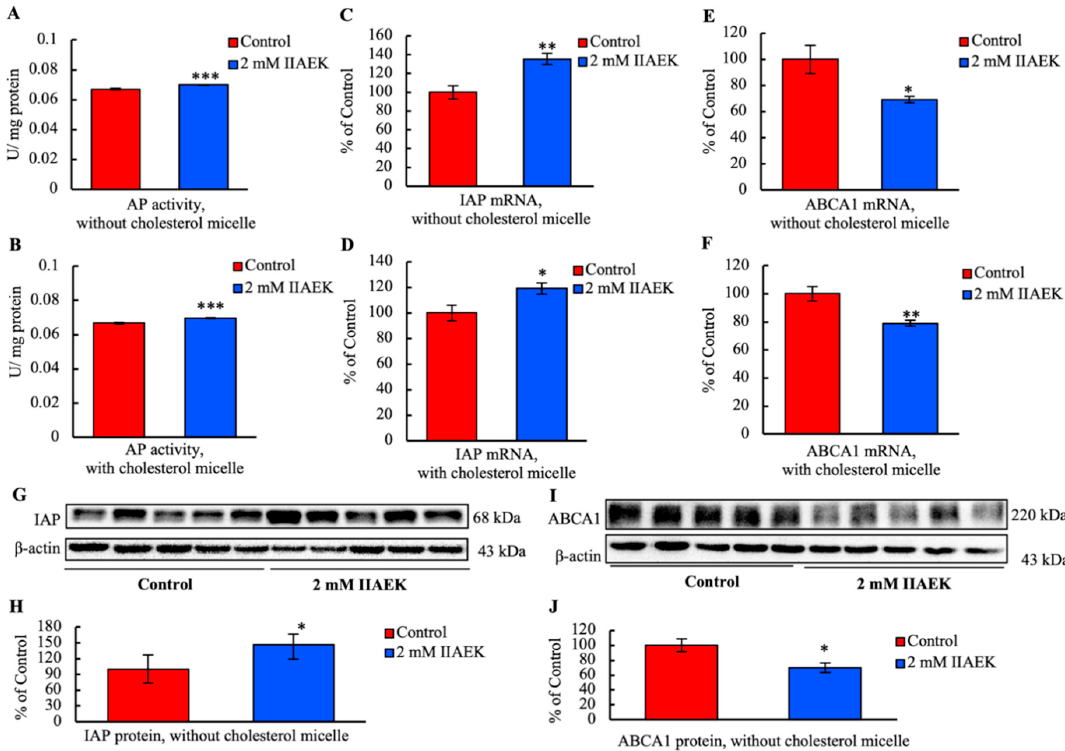
Figure 5. Effects of IIAEK on the expression of intestinal alkaline phosphatase (IAP) and the cholesterol metabolism-associated gene, ABCA1. Caco-2 cells were cultured in six-well Transwell plates. The cells were treated with serum-free medium containing 2 mM IIAEK or vehicle for 24 h. They were incubated with or without cholesterol micelle. ( A , B ) The total proteins were collected from the cells, and alkaline phosphatase (AP) activity was measured. Values are represented as means ± standard error represented by vertical bars ( n = 6 per group). ( C – F ) Total RNA was collected from the cells. The IAP and ABCA1 mRNA levels were measured by real-time PCR and normalized to the mRNA expression level of 18S ribosomal RNA. Values are represented as means ± standard error represented by vertical bars ( n = 6 per group). ( G , I ) The cell lysate was collected from the cell, separated on SDS-PAGE, and analyzed by Western blot analysis. ( H , J ) The IAP and ABCA1 protein levels were quantified with ImageJ and normalized to the level of β -actin. Values are represented as means ± standard error represented by vertical bars ( n = 5 per group). Asterisks indicate the difference from the control (* p < 0.05, ** p < 0.01, *** p < 0.001) as determined by Student’s t -test.